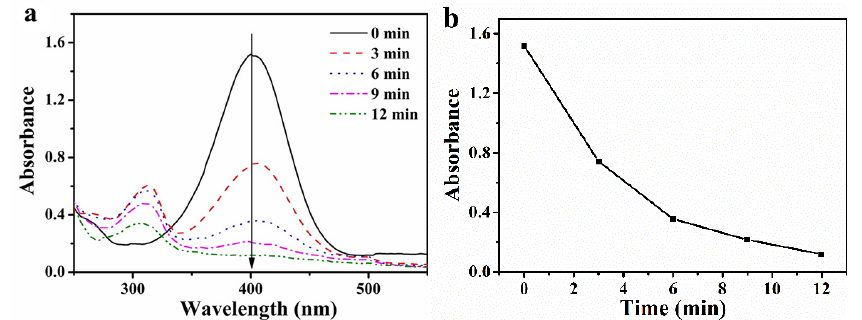
Figure 5. ( a ) The UV–Vis spectra of the reduction process of 4-NP catalyzed by PO-PdNPs 75 , ( b ) the relationship diagram of absorbance and time. relationship diagram of absorbance and